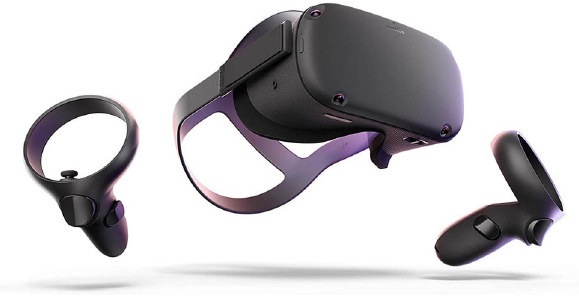
Figure 1: Oculus Quest untethered VR HMD and 2 touch